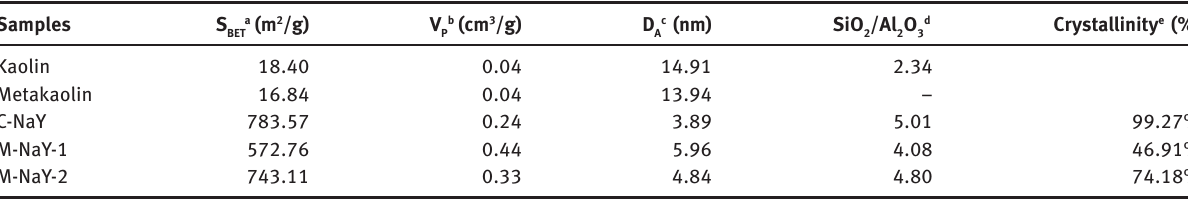
Table 2: Textural properties and structural parameters of samples.